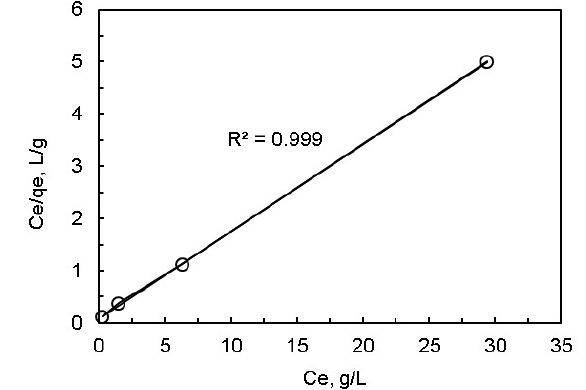
Fig. 7. The Langmuir isotherm plot for dye adsorption on pyrolusite ore.